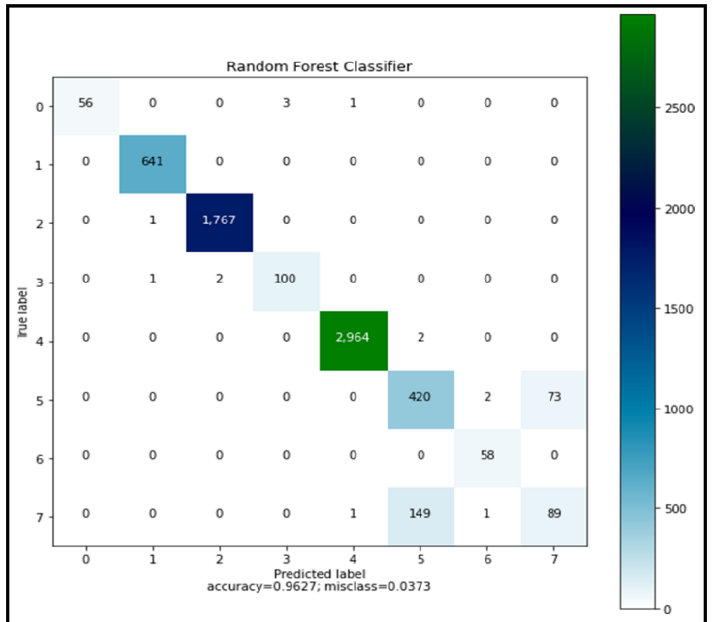
Figure 11. Confusion matrix for a random forest.